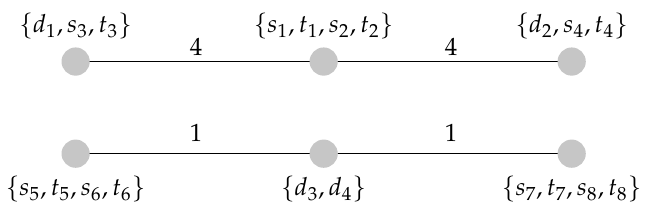
Figure 3. A worst-case instance for the CA sum of CS sum , s = t .